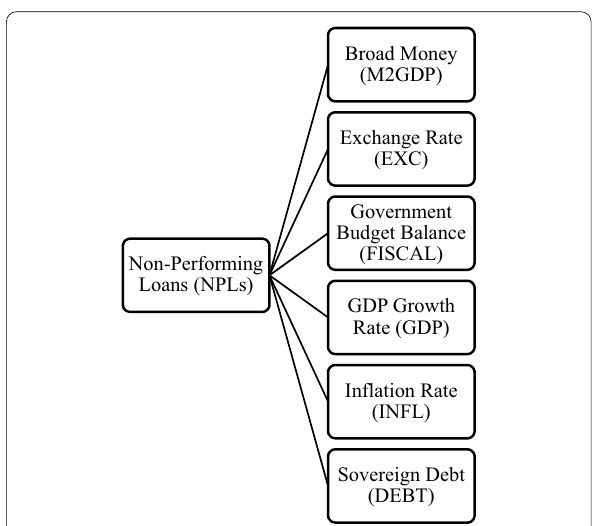
Fig. 1 Conceptual framework ( Source: Author’s